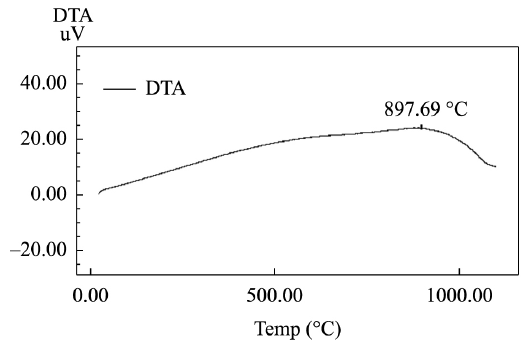
Figure 1. Differential thermal analysis (DTA) curve for uncoated diamonds.